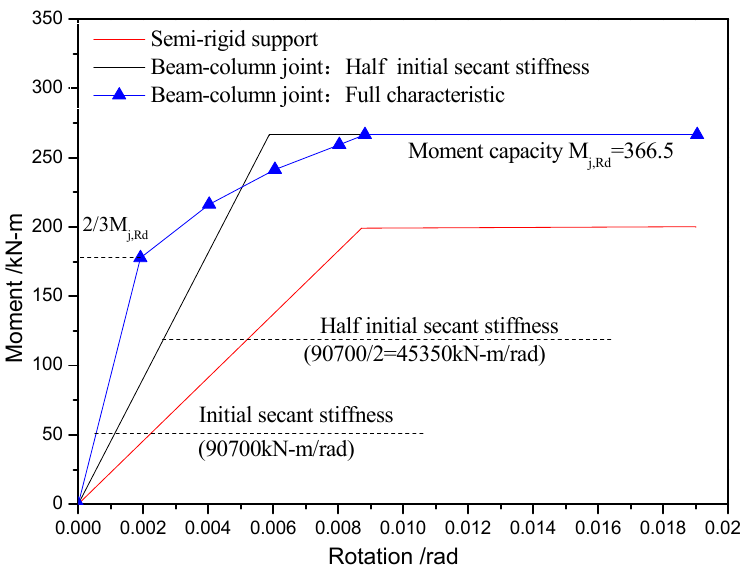
Figure 18. Load-moment curves.